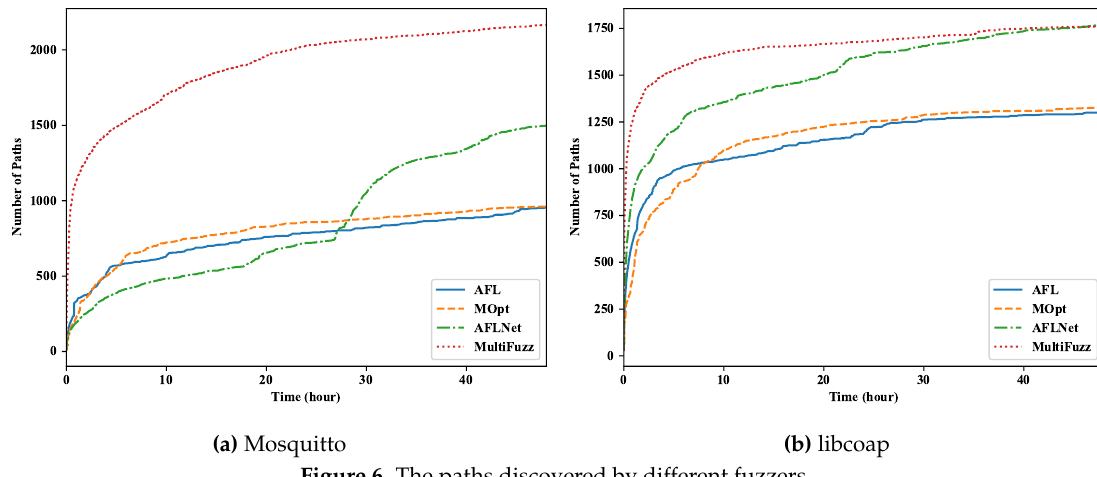
Figure 6. The paths discovered by different